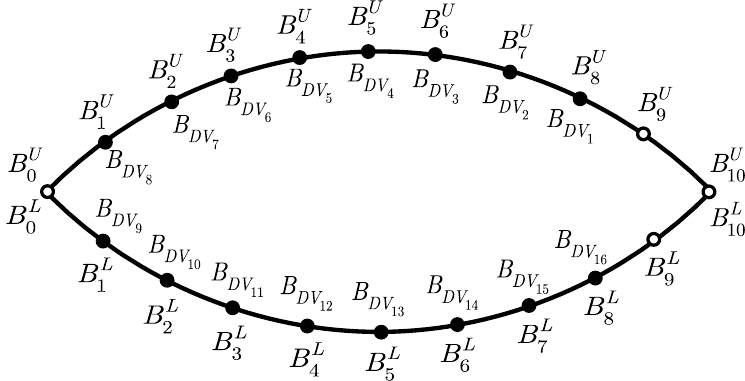
Figure 3. Definition of the design variables used for aerodynamic shape optimization. Here, the coordinates of the Bezier control points were not real and were plotted this way for the sake of simplicity in the definition.